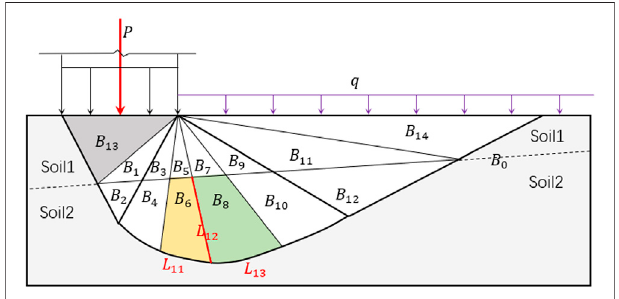
FIGURE 1 | Improved rigid block division model.